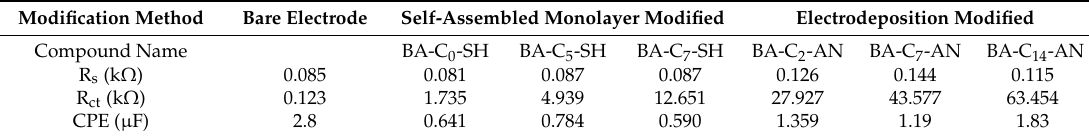
Figure 2. CV of an Au electrode of ( a , b ) bare (grey), thiol-based (red) BAs and aniline-based BA derivatives were in 10 mM ferricyanide. Electrical Impedance of thiol-based ( c ) (red) and aniline-based ( d ) (blue) BA derivatives were fitted by the Randles equivalent where experiment result showed in dot and the fitted curve in line. Table 1. Fitted circuit elements of BA derivatives on QCM electrodes.